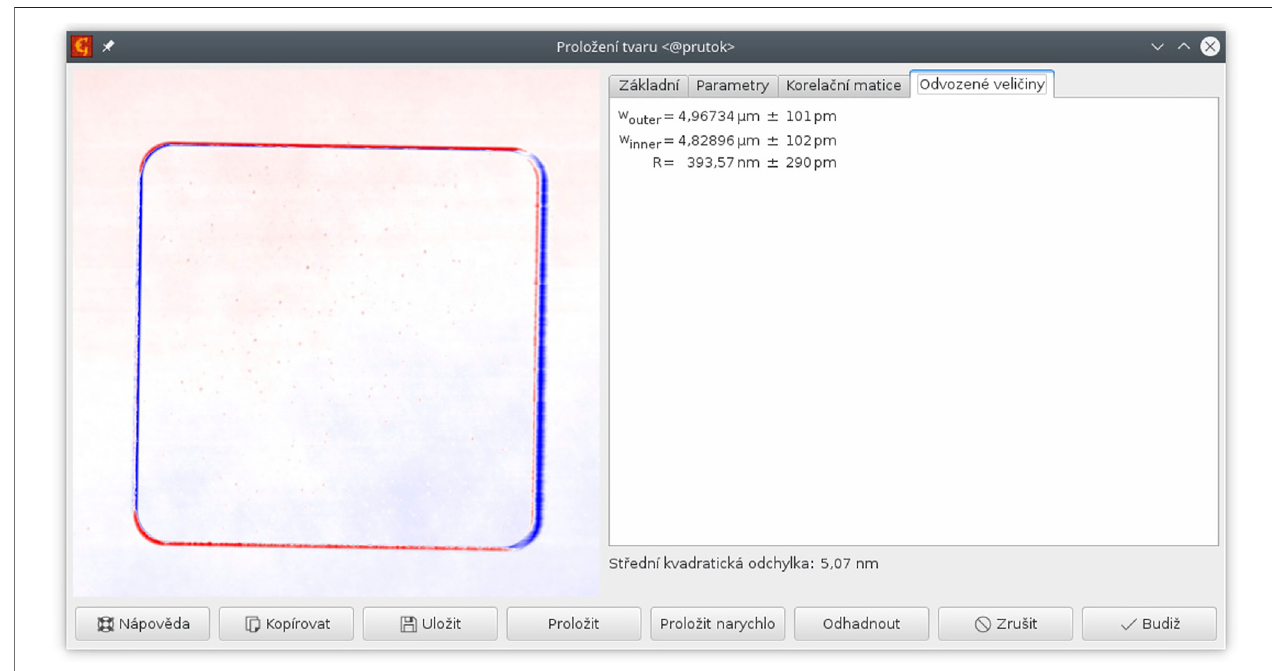
FIGURE 8 | Example for fi tted shape difference of AFM measurements.